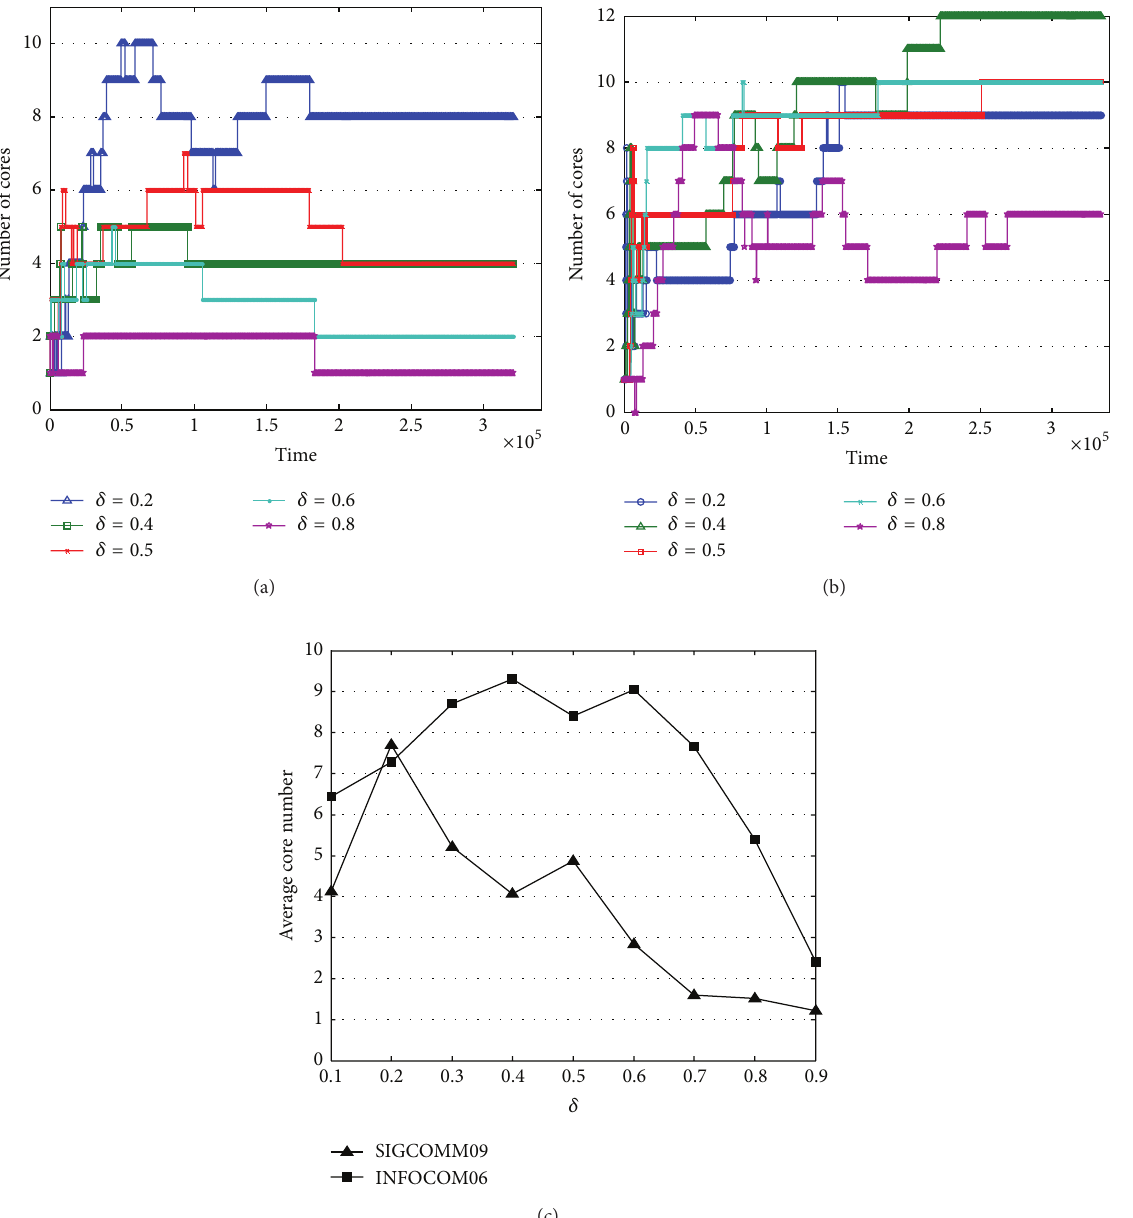
Figure 11: Number of community cores. (a) Variation in number of community core in SIGCOMM09. (b) Variation in number of community cores in INFOCOM06. (c) Average number of community cores in the two datasets under different 𝛿 .